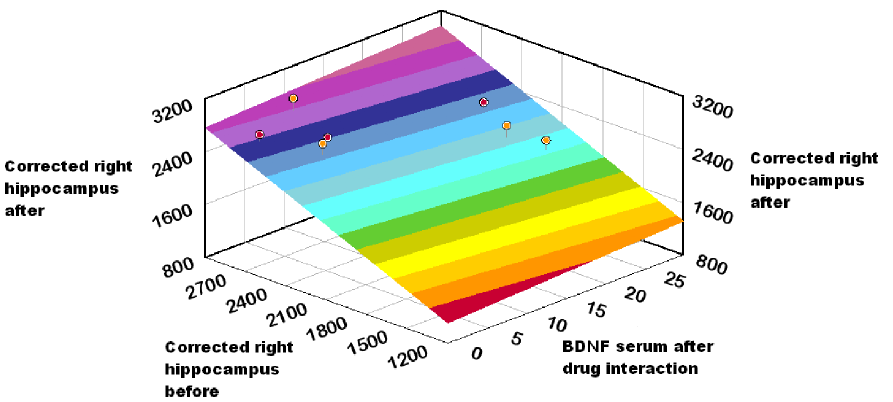
Figure 2. Model fit of corrected right hippocampus at the study endpoint (as dependent variable). Predictors: serum BDNF after drug interaction, Corrected right hippocampus before.